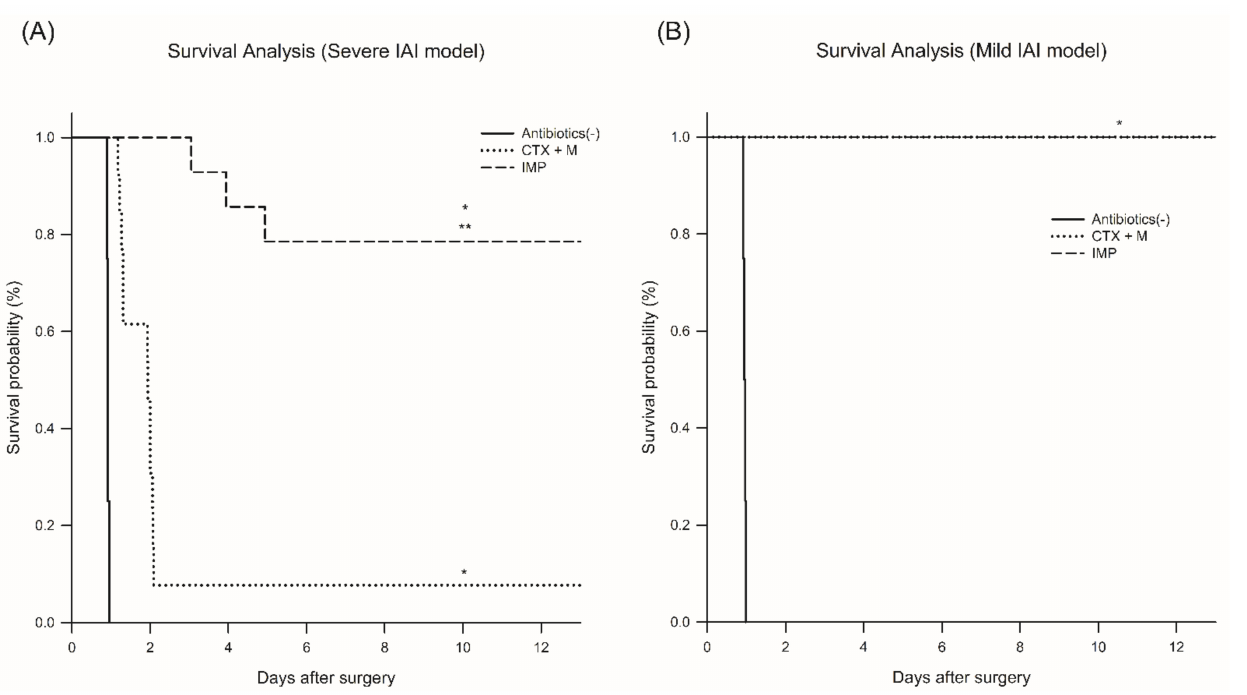
Figure 1. Survival effect of different antibiotic treatments on polymicrobial intra-abdominal infection (IAI) model. ( A ) Severe IAI model, n = 4 for no antibiotics, n = 13 for CTX + M, n = 14 for IMP. ( B ) Mild IAI model, n = 4 per group, * p < 0.05 compared with no antibiotics model, ** p compared with CTX + M model. IAI, intraabdominal infection; CTX + M, ceftriaxone with metronidazole; IMP,